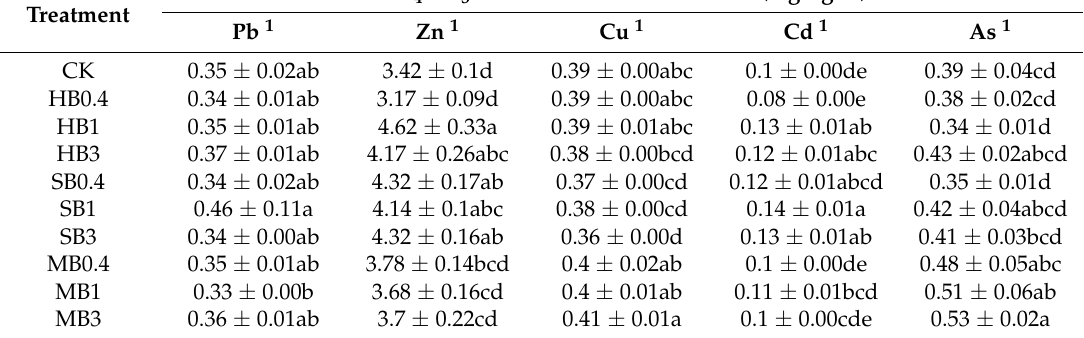
Table 4. Effects of HB, SB and MB treatments on NH 4 NO 3 -extractable Pb, Zn, Cu, Cd and As contents in mine tailings.